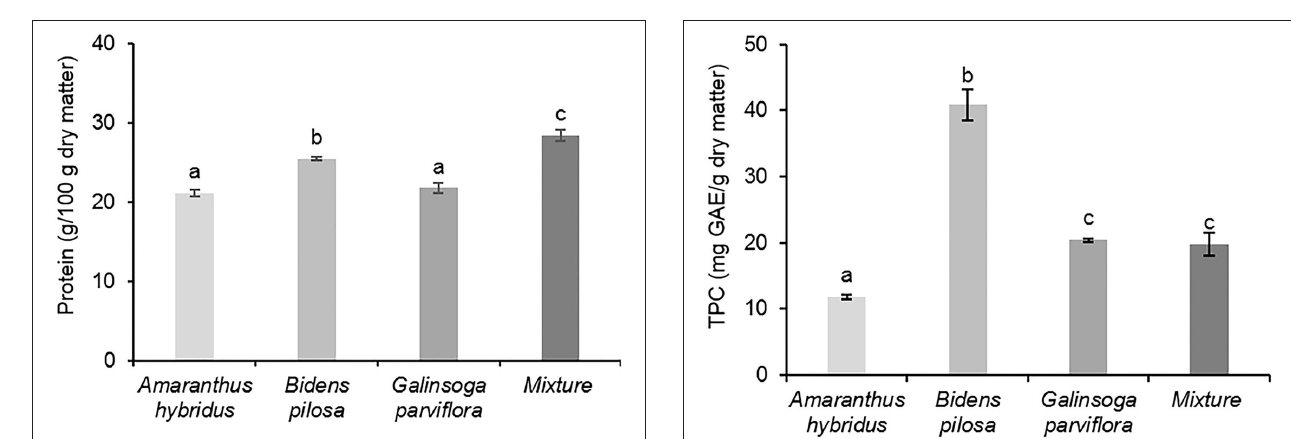
FIGURE 5 | Total phenolic contents (TPC) of lombi . Error bars represent ± standard deviation ( n = 9). Different letters indicate significant differences between